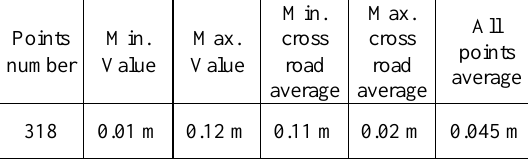
Table 3. Statistics of the manual measured differences